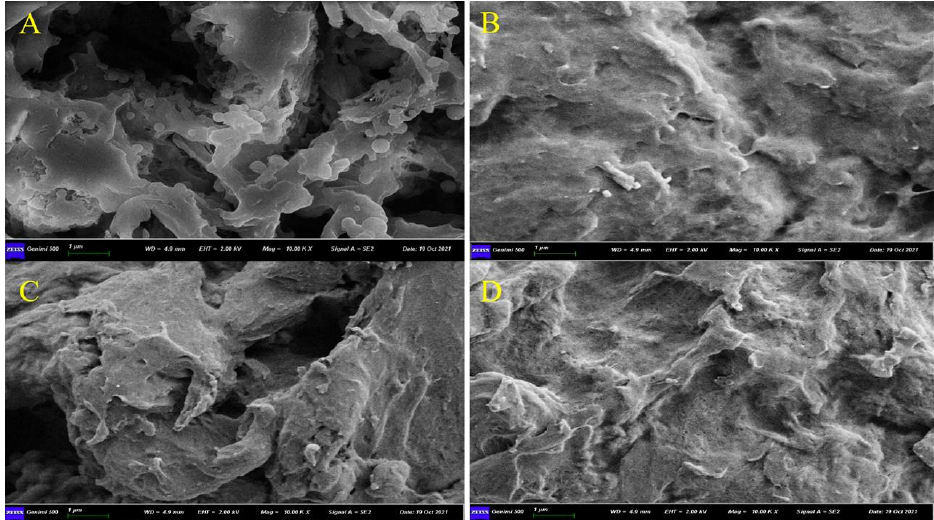
Figure 2. SEM images of ( A ) M5, ( B ) MN5, ( C ) D2, and ( D ) DN2. To determine the improvement of the MIPs by using RTILs, the swelling perfor- mance of M5; D2; and their corresponding, controlled polymers was carried out in water (Figure 3). The least swelling was found in M5 when RTIL and DMSO were used as a binary solvent, followed by polymers synthesized with neat-DMSO-based MIPs, while the non-imprinted polymers showed maximum swelling. The lesser swelling indicates that the polymers had a porous structure, where the water was embedded inside the cav- ities, causing lesser swelling [48], indicating that M5 has a pronounced adsorption ability for ABM. Figure 3. Swelling performance of the polymers. The thermal stability of the prepared polymers was investigated with TGA, pre- sented in Figure 4. The results revealed that weight loss was observed in three stages. First, minor weight loss was observed in the range of 50 to 100 °C, which indicates the residual water loss; the second loss occurred in the range of 300 to 350 °C, which repre- sents the decomposition of the polymers, and the third weight loss was found after 450 °C, which contribute, to the organic matter decomposition. The TGA analysis represents that the polymers exhibited higher thermal stability up to 300 °C [49,50].